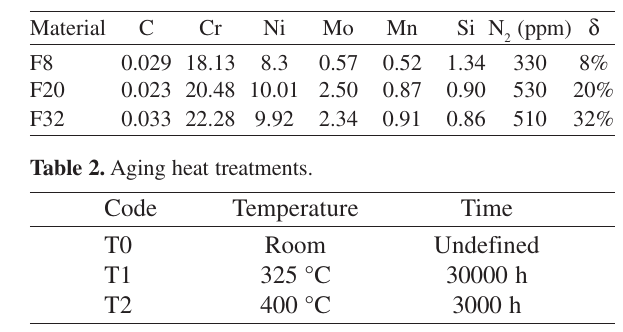
Table 1. Composition and ferrite content of materials.